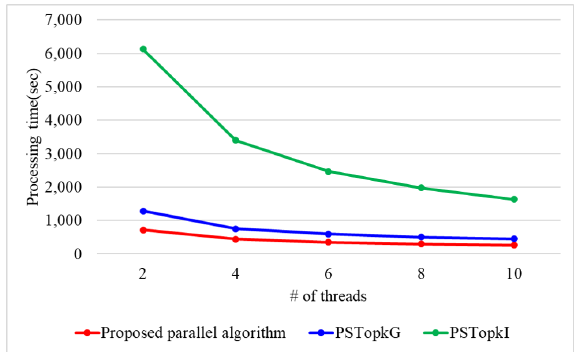
Figure 17. Processing time with a varying number of threads in real